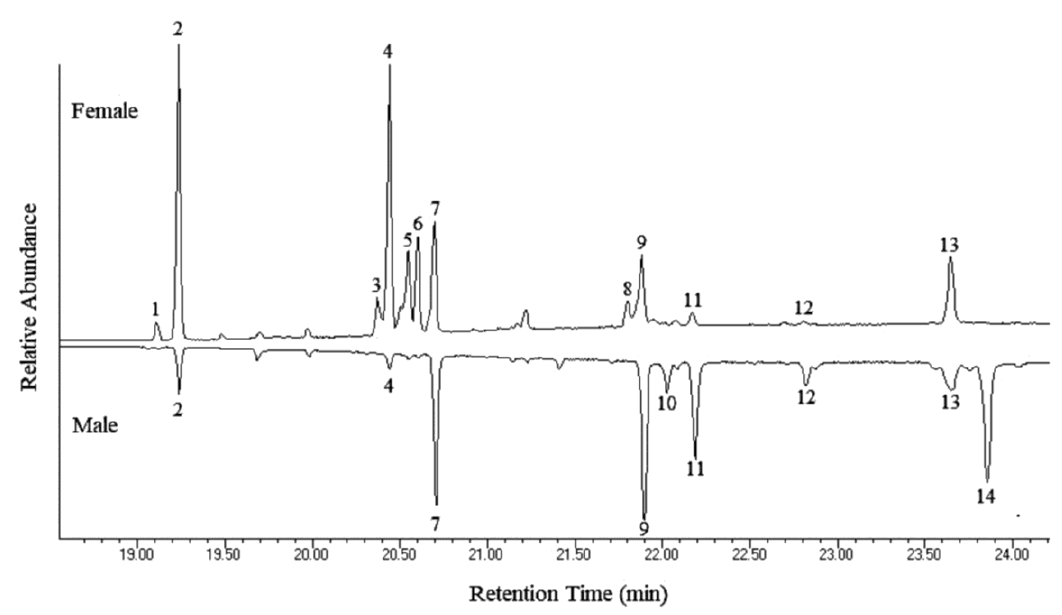
Figure 13. Gas chromatogram profiles of solvent extracts of A. bungii antennal secretions: female (top) versus male (bottom, inverted). Table 2. Antennal secretion hydrocarbons of male and female A. bungii . Peak